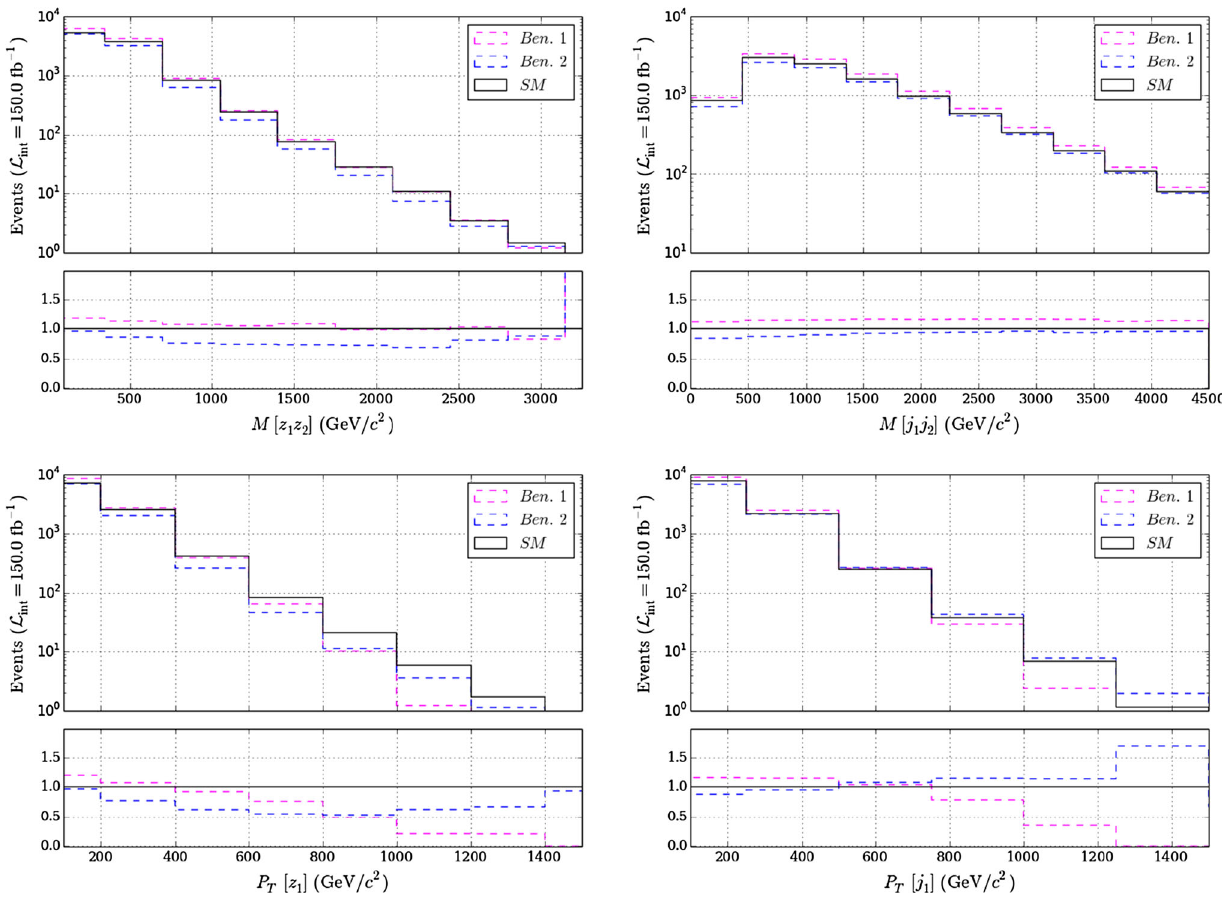
Fig. 6 Bosonic benchmarks B1 and B2. The “local” effects on individ- ualobservablesandbinsareverydifferentfromtheglobalenhancement or decrease of the cross section. The observables related with transverse